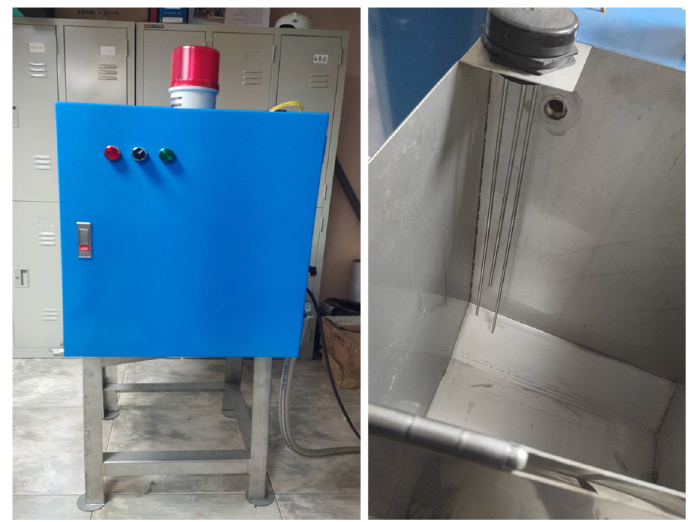
Figure 4. Oil–water mixing machine equipment.